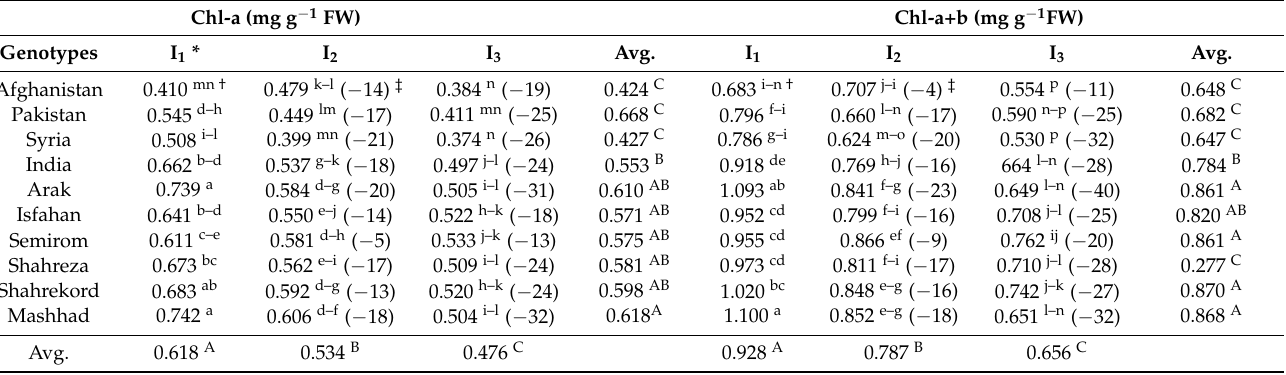
Table 3. Mean comparison of the effect of irrigation regime (I), genotype (G), and their interaction on Chl-a and Chl-a+b of black cumin.